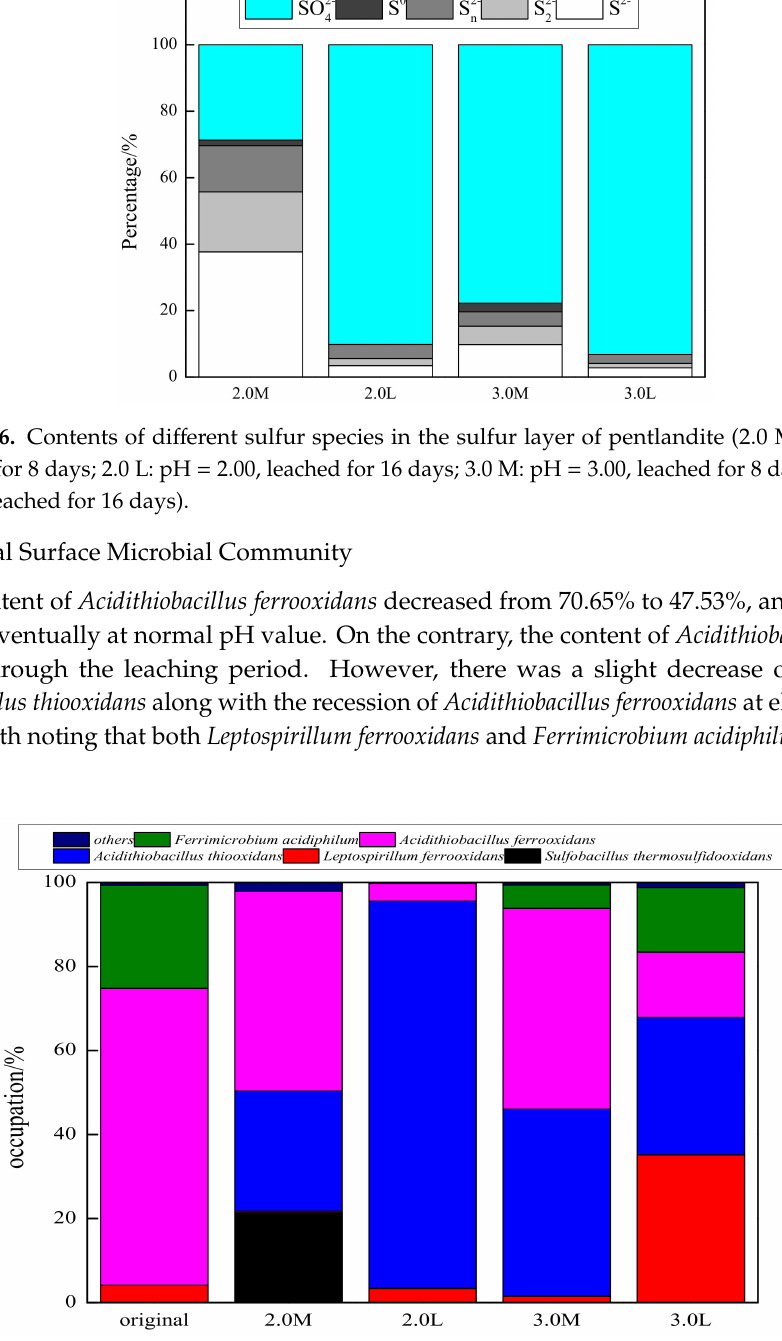
Figure 17. Bacterial community of the original leaching bacteria and leaching bacteria adsorbed on the leached samples (original: original leaching bacteria; 2.0 M: pH = 2.00, leached for 8 days; 2.0 L: pH = 2.00, leached for 16 days; 3.0 M: pH = 3.00, leached for 8 days; 3.0 L: pH = 3.00, leached for 16